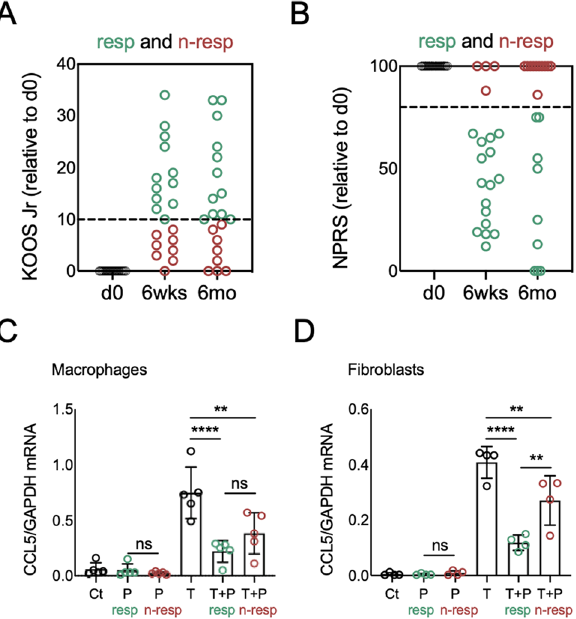
Figure 5. Evaluation of the bioactivity of PRP from patients classified as responders and non-responders using patient-reported outcomes . Responders (resp, green) and non-responders (n-resp, red) to PRP treatment identified using ( A ) Knee injury and Osteoarthritis Outcome (KOOS JR) Score and ( B ) Numeric Pain Rating Scale (NPRS) Score in patients with completed questionnaires at baseline (d0) and the 6 weeks (6 wks) and 6 months (6 mo) follow up time-points. For selection of PRP for analyses, patients were categorized as responders or non-responders based on achievement of minimal clinically important difference (MCID) thresholds (dotted lines) of 10-point improvement in KOOS JR and 20% improvement in NPRS at 6 months after PRP injection. Scores are represented as changes relative to self-reported baseline levels (d0) for each patient and each score. RTqPCR analyses of CCL5 mRNA in ( C ) macrophages and ( D ) fibroblasts left untreated (Ct) or treated with TNFα (T), PRP (P) or TNFα + PRP (T + P) for 24 h, using PRP from responders or non- responders. RTqPCR data is represented as mean ± S.D (error bars) of 5 (macrophages) and 4 (fibroblasts) independent experiments. ** p < 0.01, **** p < 0.0001 by ANOVA followed by Tukey’s post-hoc test. ns = not significant. Graphs were created with GraphPad Prism